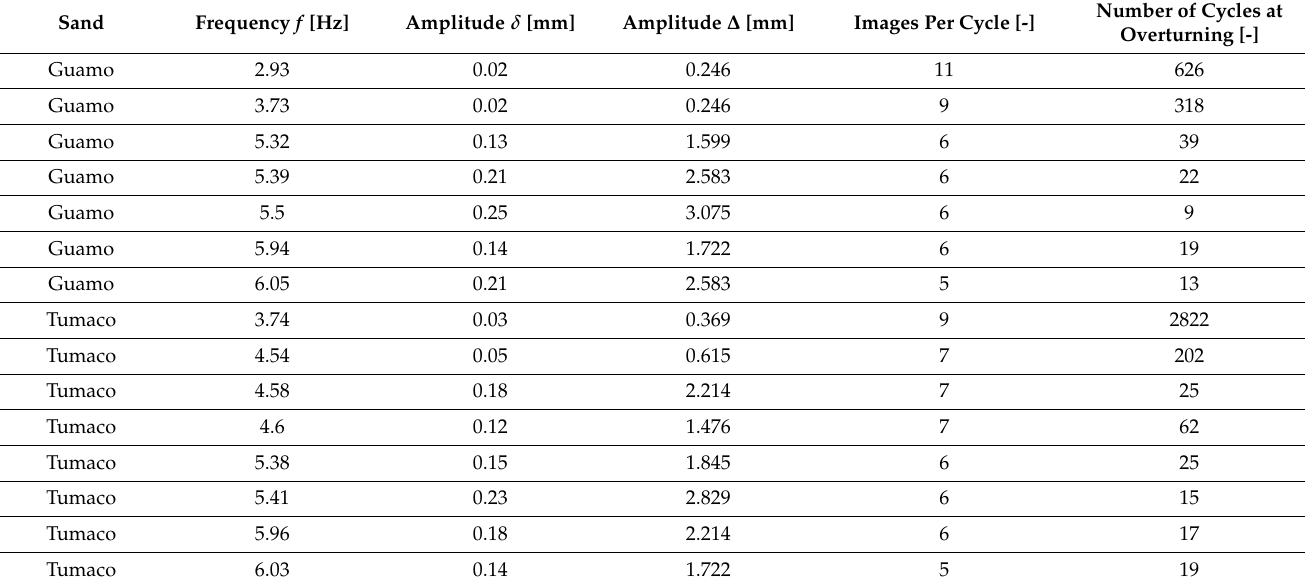
Figure 14 shows the relationship between the cycle number at overturning (NCO), the effective grain size ( D 10 ) for excitation frequencies between 2.5 Hz and 6.5 Hz, and vertical displacement amplitudes between 0.1 mm and 0.2 mm. These values were obtained from the trending lines in Figure 13. It is possible to note that D 10 influenced the NCO to low excitation frequencies, and their relationship was inversely proportional because D 10 regulates the flow of water through soils and can control the mechanical behavior of soils since the coarser fractions may not be ineffective in contact with each other; that is, they float in a matrix of finer particles [40].